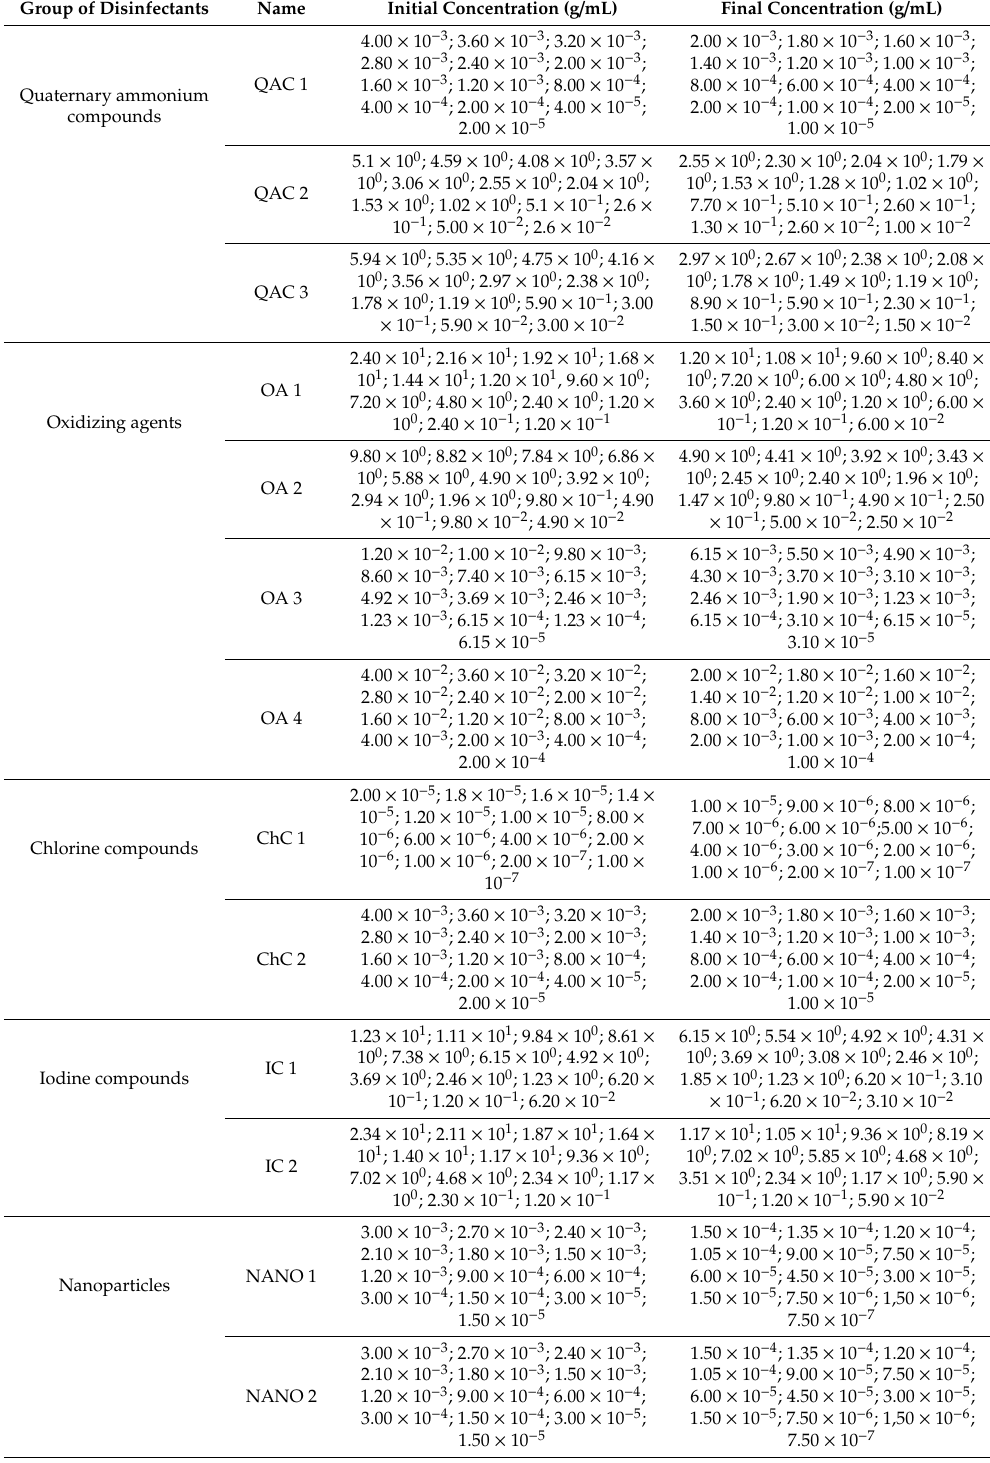
Table 2. The specific concentrations for particular tested